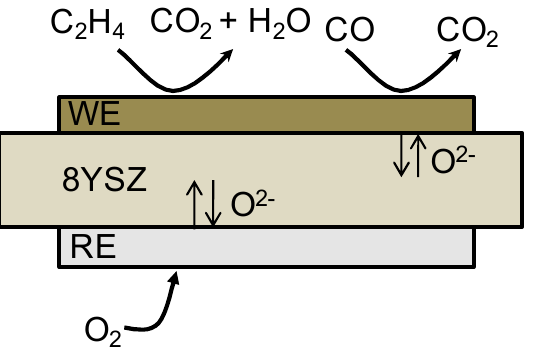
Figure 1. Scheme of the sensor. The device consists of a dense 8YSZ electrolyte with platinum reference electrode ( bottom ) and distinct materials as working electrode ( top ).